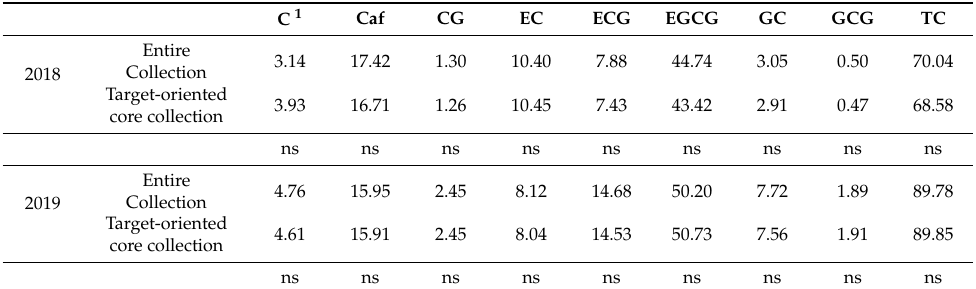
Table 6. Phytochemical diversity comparison between the entire collection and core collection of tea accessions (mg /